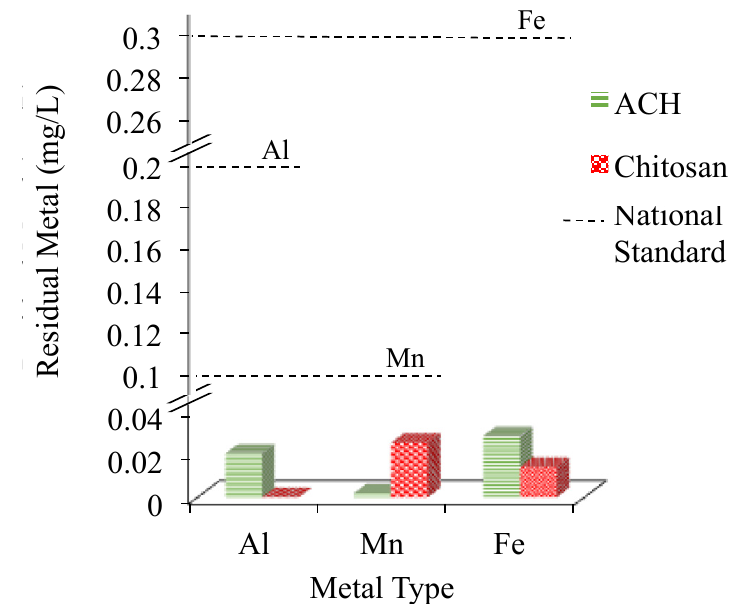
Figure 5. Residual concentration of Al, Mn, and Fe in treated water using 10 mg/L coagulant dosage of ACH and chitosan (initial water turbidity: 826.30 NTU, pH: 5.21; initial metal concentration: Al, 75.14 mg/L; Mn, 0.10 mg/L; Fe, 7.70 mg/L; national standard of drinking water content; Al = 0.20 mg/L, Mn = 0.10 mg/L, and Fe = 0.30 mg/L).